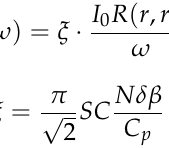
In Formula (7), I 0 is the maximum intensity of the laser, ξ is the coefficient which represents the conversion of light energy into mechanical energy, through which the concentration of the gas can be